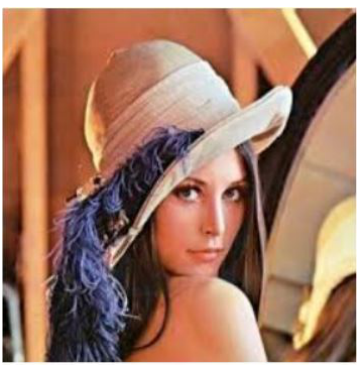
Figure 10. Decoded image of Lena after decryption process - size 27.9 KB